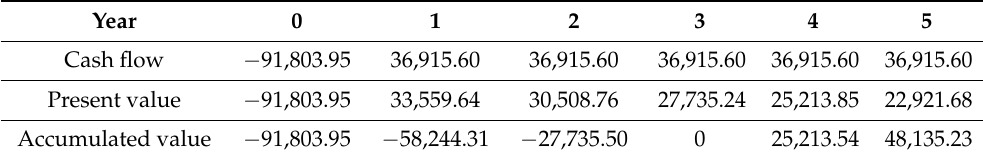
Table 5. Annual cash flow for the bio-oil produced by pyrolysis of lipid-based material and discounted payback analysis, net present value (NPV) analysis, internal rate of return (IRR) analysis, and profitability index